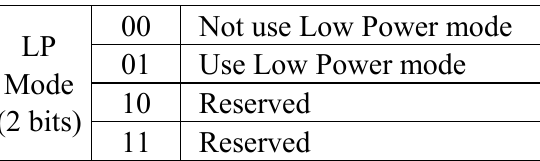
Table 6. NAV flag.